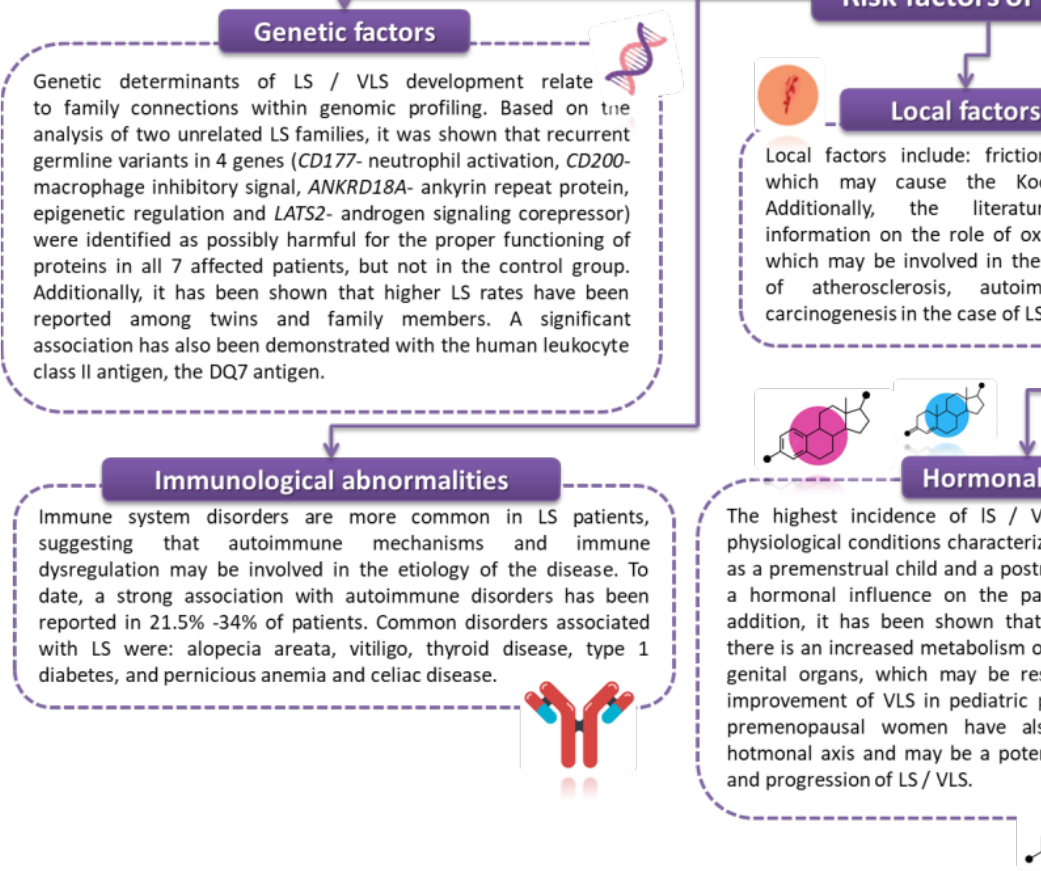
Figure 2. Risk factors for the occurrence of LS/VLS based on [26 – 36].